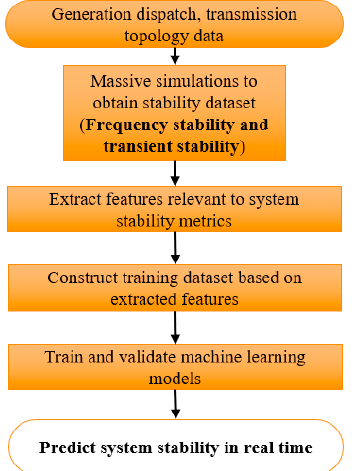
Figure 2. Procedure of the proposed AI-based stability assessment method.